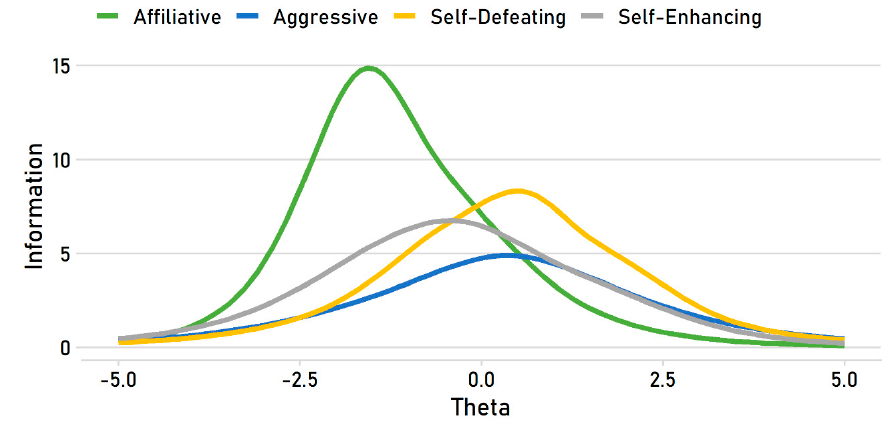
Figure 4. Test information functions for the HSQ subscales.